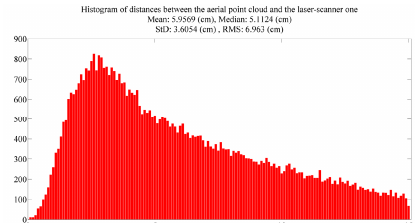
Figure 8. The accuracy analysis of the point cloud, histogram of 3D distances between image and laser point clouds in